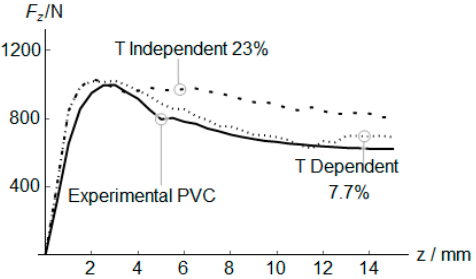
Figure 13. Experimental vs. predicted mean F z values and estimation error e of temperature-dependent and temperature-independent models for PVC.